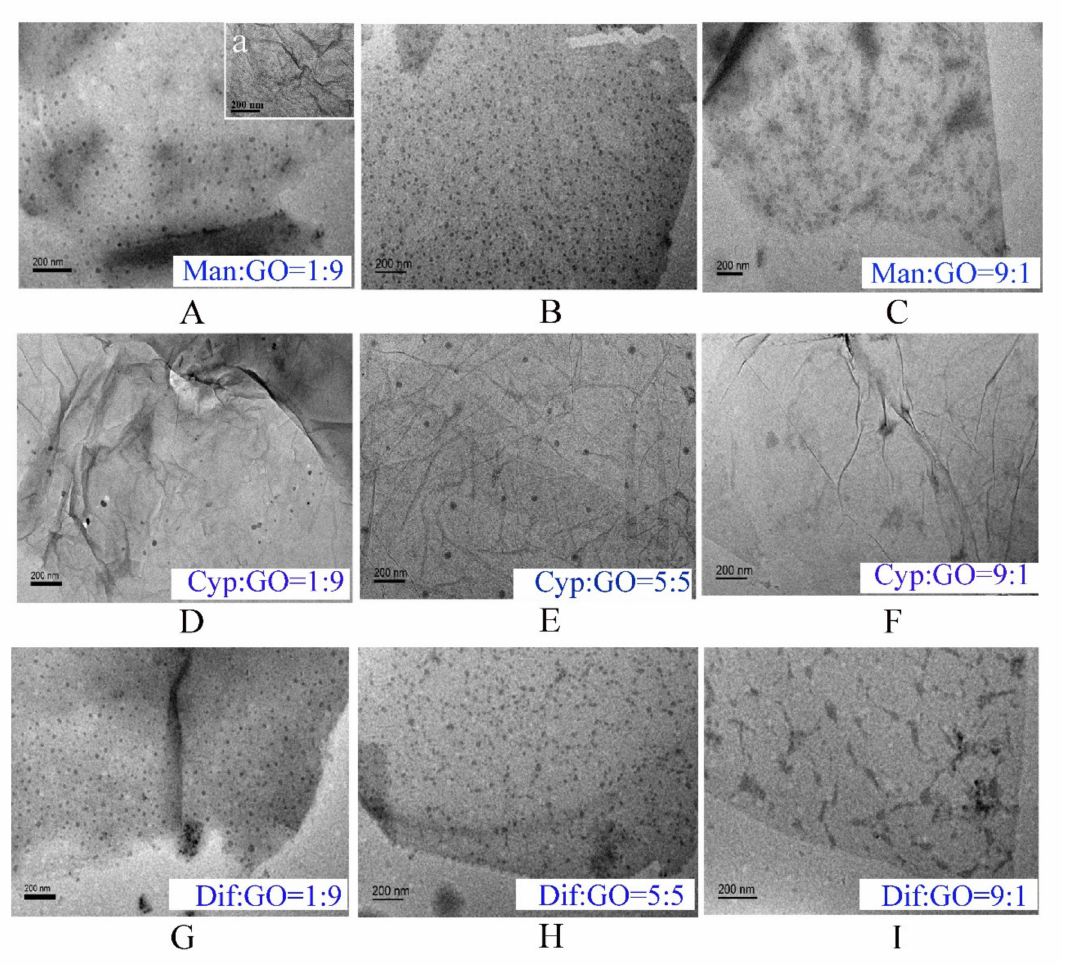
Figure 2. Characterization of the formulated GO–fungicides. TEM image of GO (Aa); GO–fungicides with the ratio of Man and GO at 1:9 ( A ), 8:2 ( B ) and 9:1 ( C ); the ratio of Cyp and GO at 1:9 ( D ), 5:5 ( E ) and 9:1 ( F ); and the ratio of Dif and GO at 1:9 ( G ), 5:5 ( H ) and 9:1 ( I ),